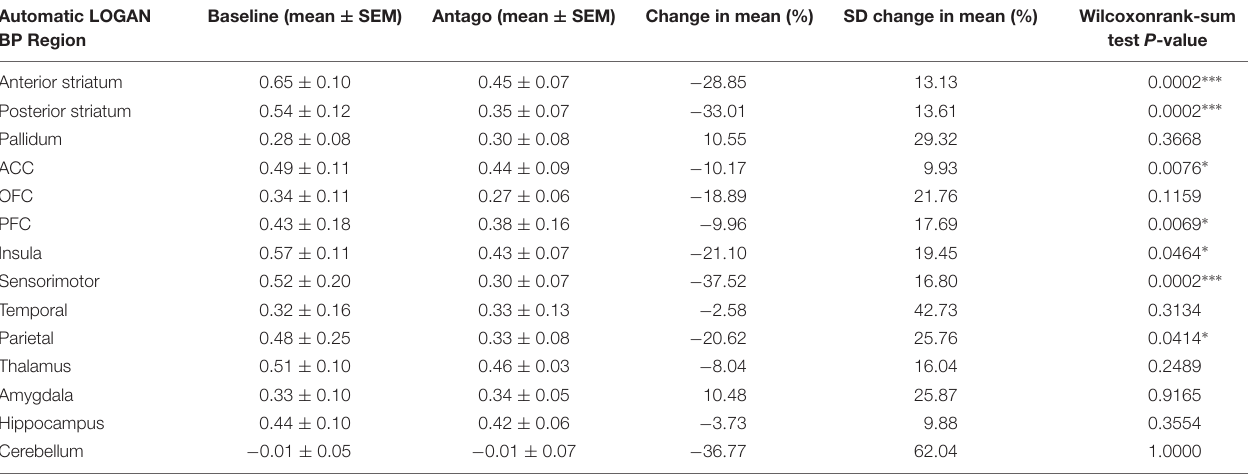
TABLE 2 | Effect of SB258585 pre-injection on BP ND characteristics using manual and automatic spatial registrations with the Logan model. Automatic LOGAN BP